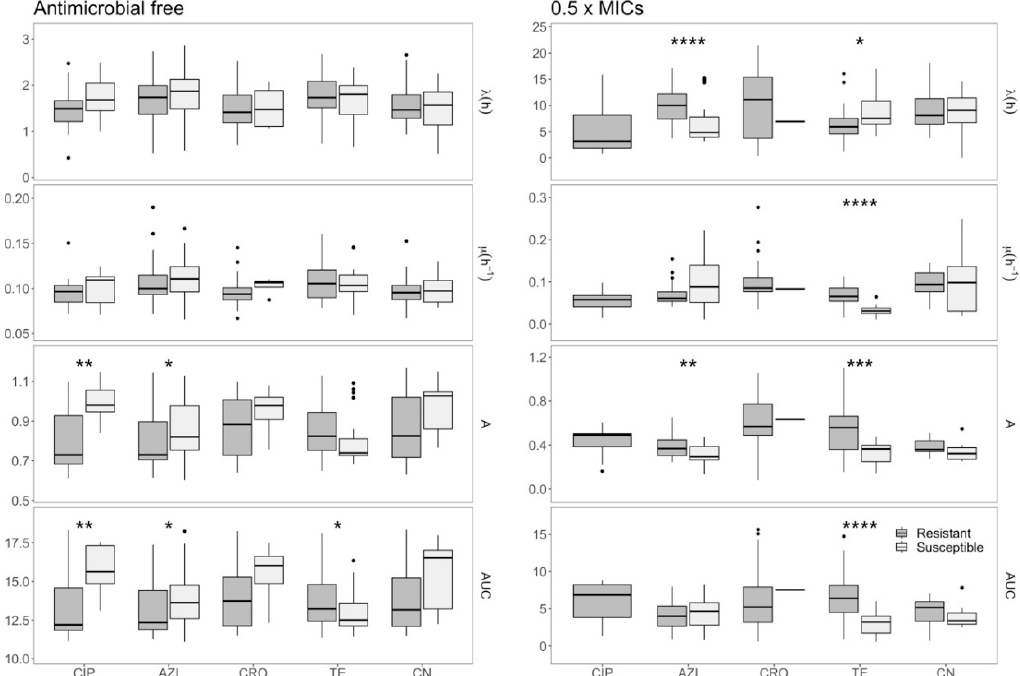
Figure 3. A comparison between the growth features for susceptible isolates and those for resistant isolates. From top to bottom, maximum cell density (A), maximum growth rate ( µ ), lag-phase period ( λ ), and area under the curve (AUC) of resistant isolates (dark gray) and those of susceptible isolates (light gray) without antimicrobial (left) and at half MICs (right). *: p -value < 0.05, **: p -value < 0.01, ***: p -value < 0.001, ****: p -value < 0.0001.